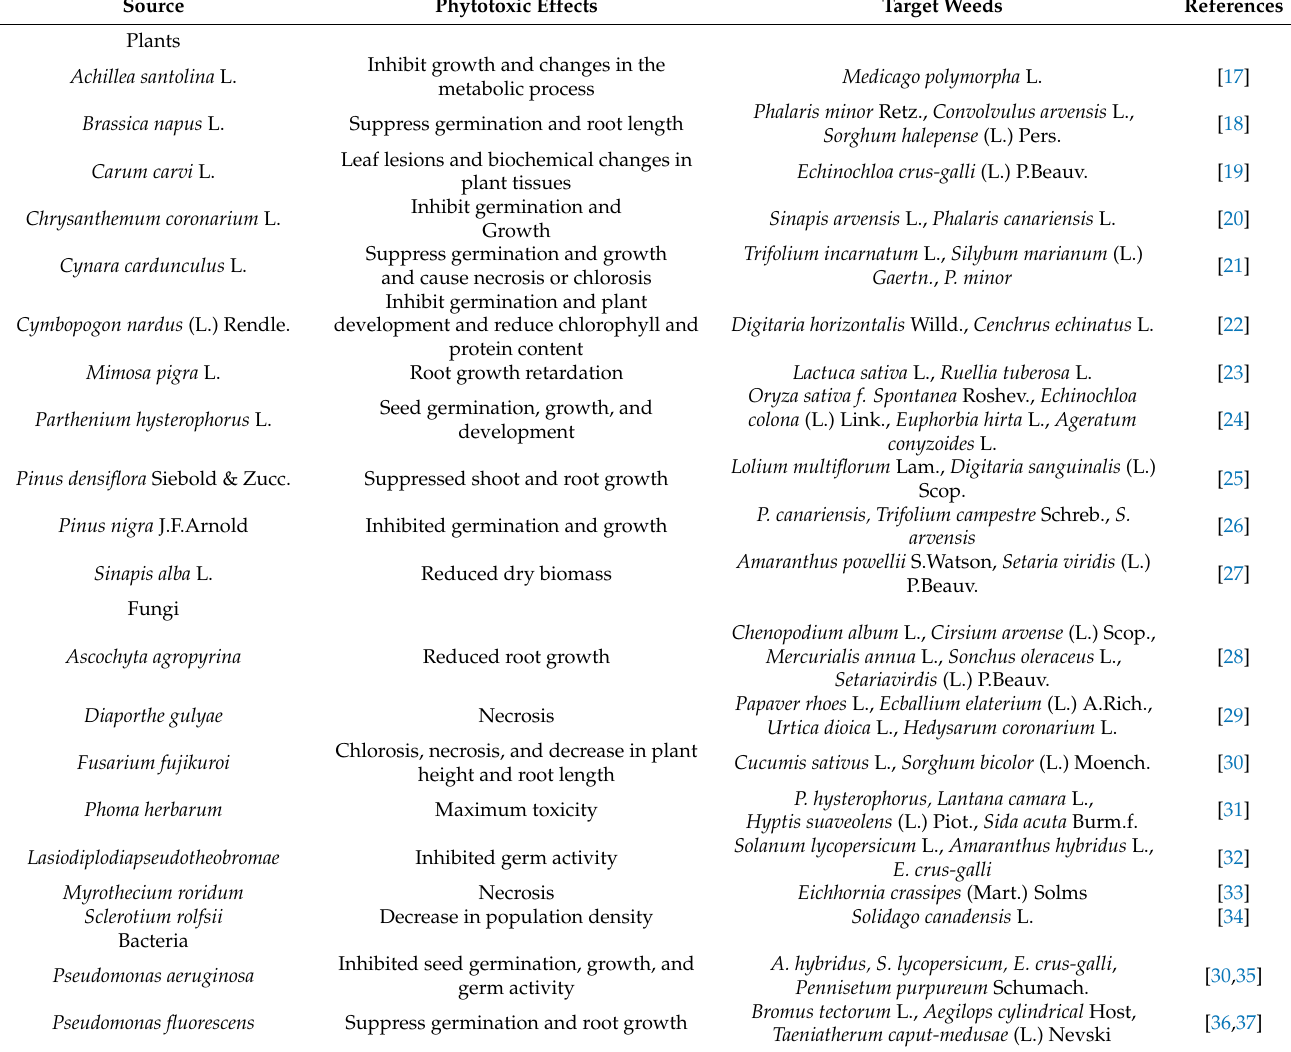
Table 1. Development of bioherbicides from different sources with their target